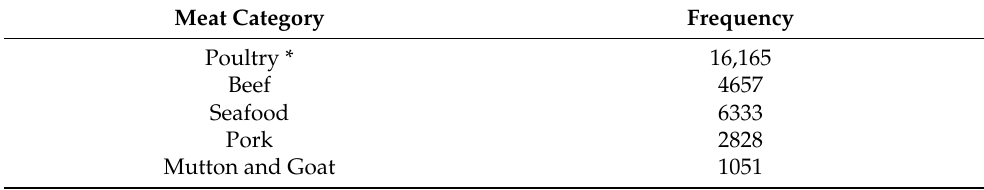
Table 4. Meat categories tweeted in connection with the hashtag #foodblogger on Twitter. Meat Category